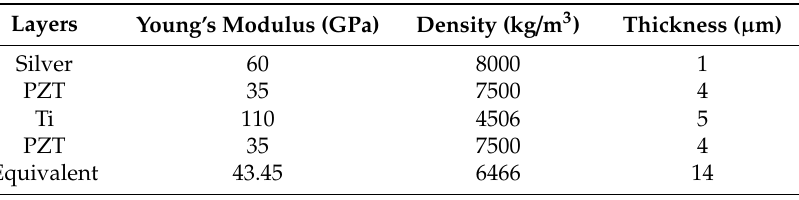
Table 1. Parameters used in the ANSYS simulation.